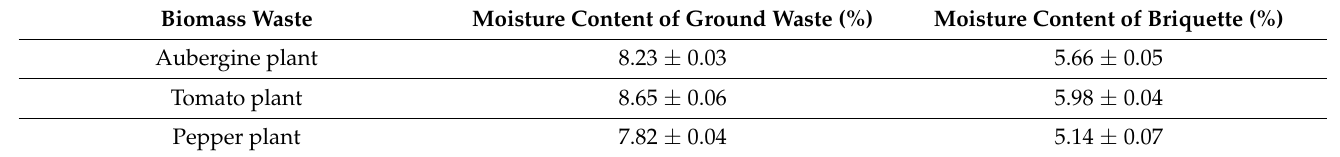
Table 2. Moisture contents of bio-briquettes (on average) obtained with the prototype machine. Biomass Waste Moisture Content of Ground Waste (%) Moisture Content of Briquette (%) Aubergine plant Tomato plant Pepper plant Note: ± , standard